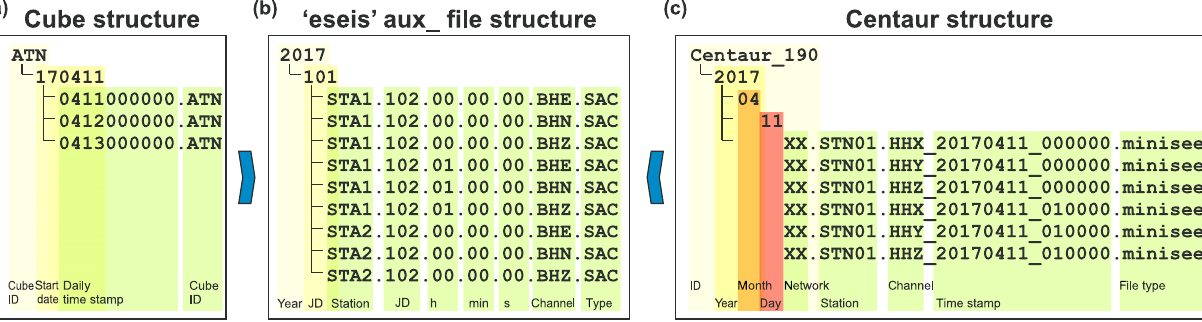
Figure 2. File organisation from the commonly used data loggers Digos DataCube (a) and Nanometrics Centaur (b) and how they are converted to the standard structure used by most of the auxiliary functions of the “eseis” package. After conversion, seismic files are organised into year and Julian day directories and within these as file names denoting station ID, Julian day, hour, minute, second, channel, and file name